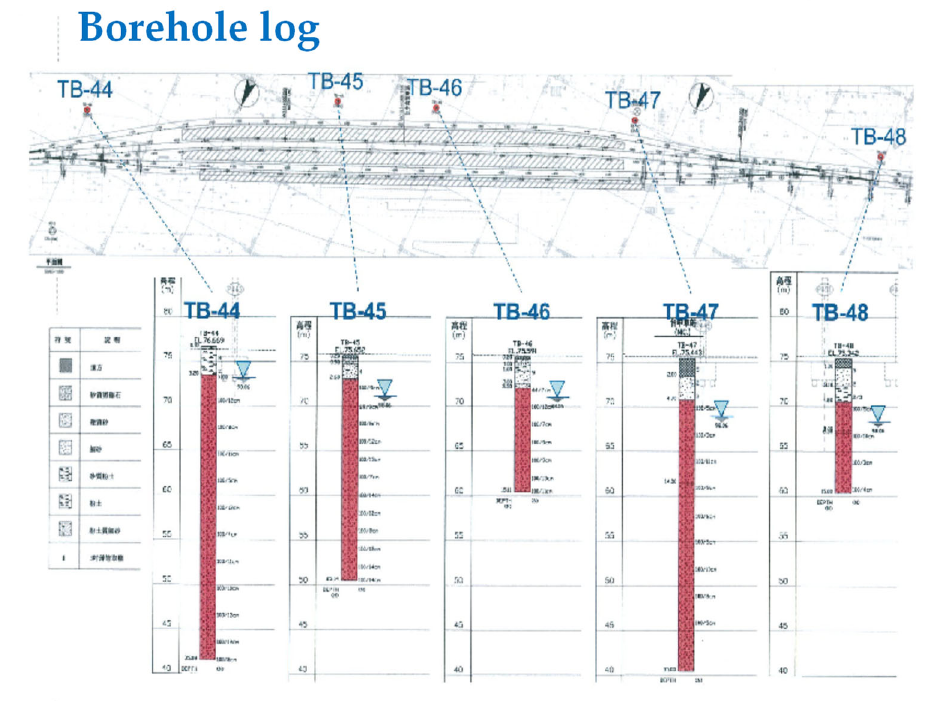
Figure 6. Borehole log for the site under consideration.